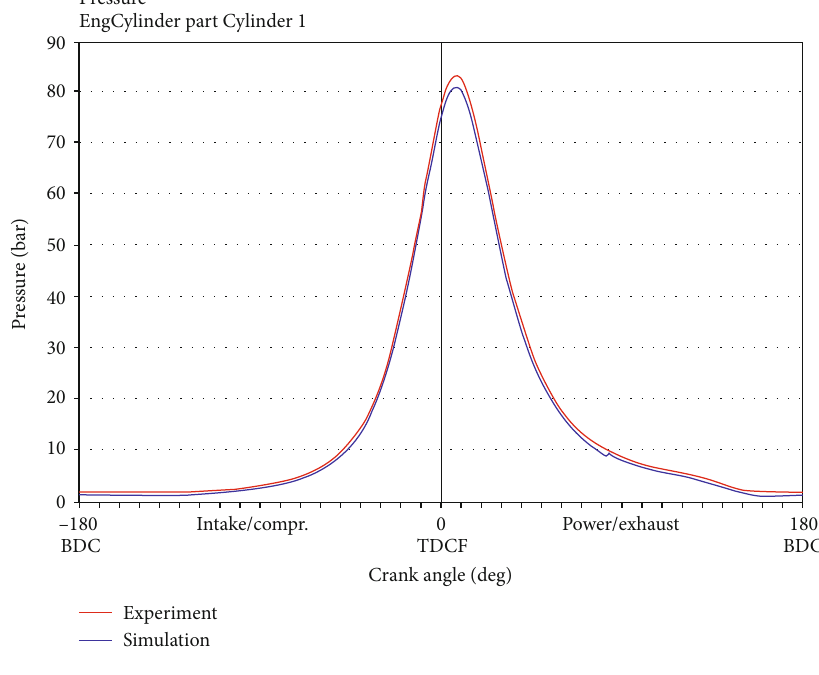
Figure 3: Cylinder pressure curve at 2700r/min.